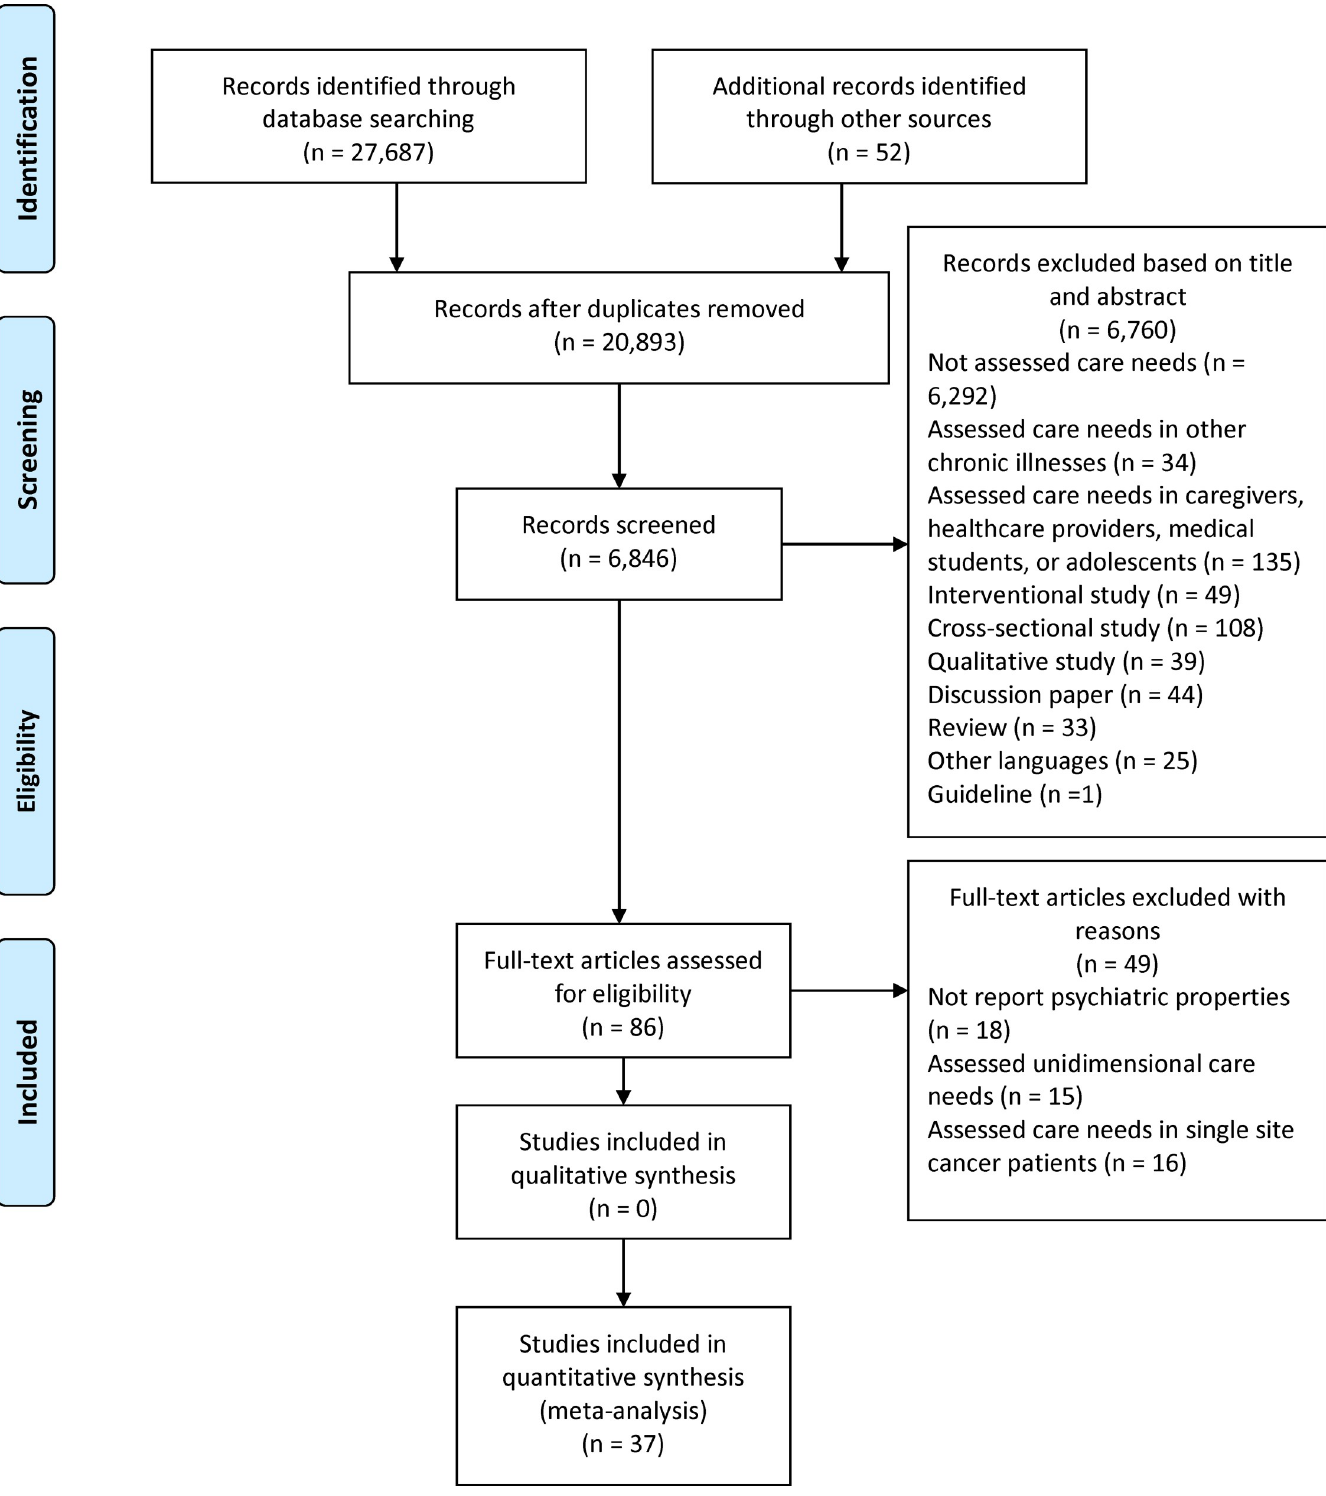
PLOS ONE | https://doi.org/10.1371/journal.pone.0210242 January 8,